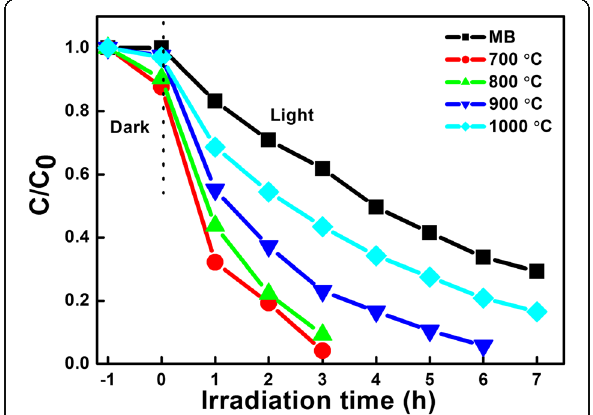
Fig. 5 Photo-degradation of MB with respect to the irradiation time using LiNb 3 O 8 powders exposed to UV light. Absorption ability of LiNb 3 O 8 powders is tested after stirring for 1 h in dark to achieve the equilibrium